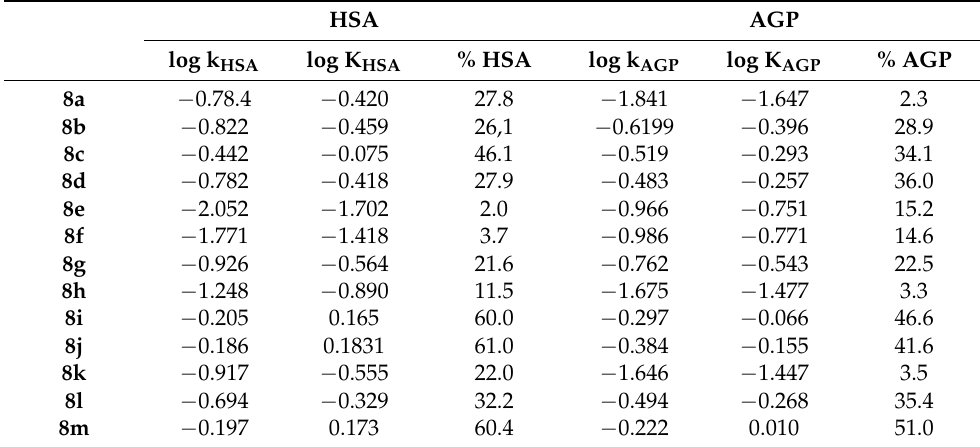
Table 7. The log k values of the compounds obtained using the human serum albumin (HSA) and α 1 -glycoprotein (AGP) columns, with the log K values obtained from a calibration curve (log binding equilibrium constant) and calculated % plasma protein binding (% PPB) (% HSA, % AGP).